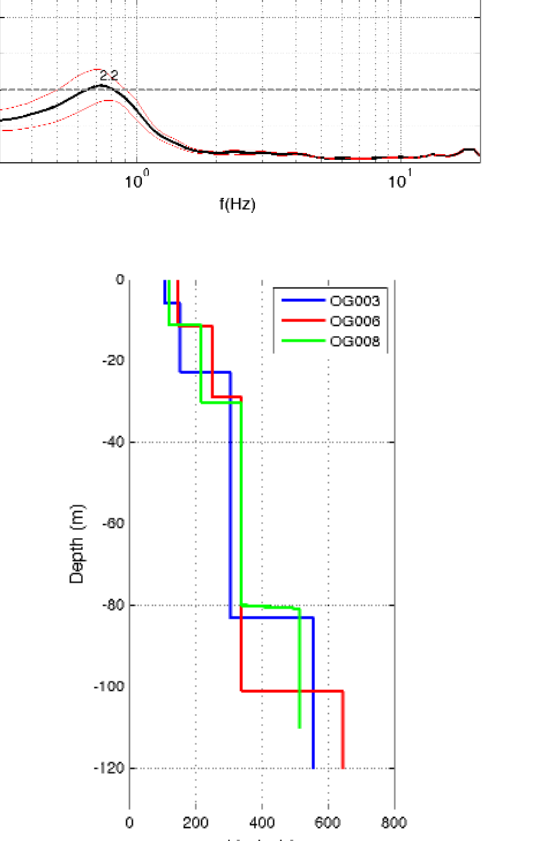
Figure 5. Vs estimation by the ESAC method at the OG003, OG006 and OG008 sites.